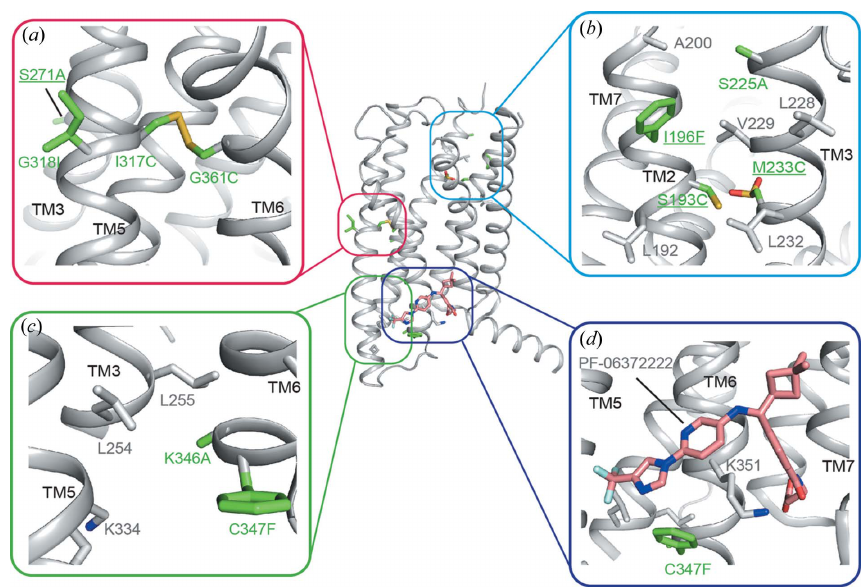
Figure 1 Locations of the ten thermal-stabilized mutations. ( a )–( d ) The original structure of inactive GLP-1R in complex with PF-06372222 (PDB entry 5vew; Song et al. , 2017) is shown as a gray cartoon, with mutations as green sticks and other interacting residues as gray sticks. Mutations analyzed in the current study are